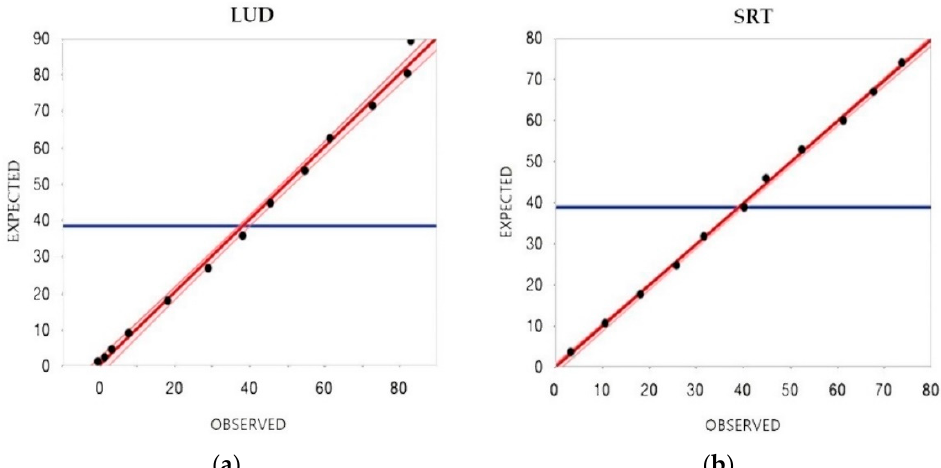
Figure 1. Comparison between observed and expected results: ( a ) Linearity under dilution (LUD) of PTH concentration in a pool of sera serially diluted with distilled water. ( b ) Spike-recovery test (SRT) of PTH concentration in a pool of sera with low PTH concentration spiked with increasing amounts of a serum pool with high PTH concentration. The solid line indicates the linear association between expected and observed results. The blue line indicates the expected